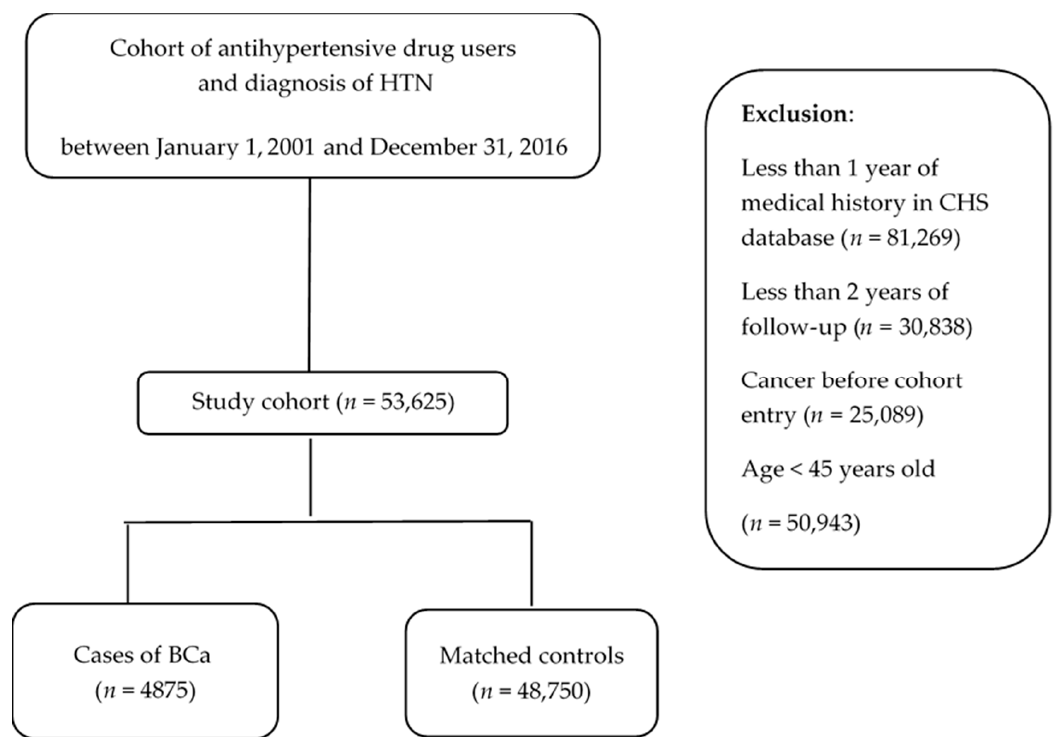
Figure 1. Study flow chart. Following study cohort formation, all BCa cases and matched controls were identified. CHS—Clalit Health Services; HTN—hypertension; BCa—breast cancer.